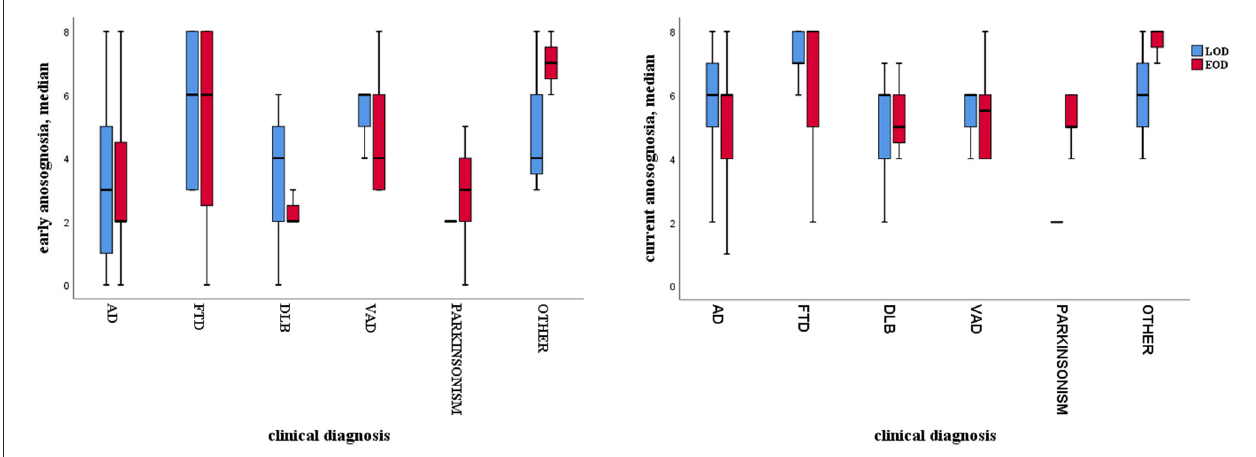
FIGURE 2 | Boxplot of anosognosia level in EOD and LOD for each diagnostic subgroup; on the left, early anosognosia; on the right, current